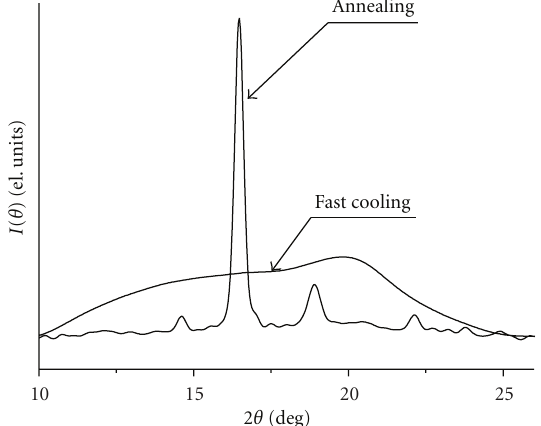
Figure 5: X-ray di ff ractograms for the CPL1/130 ◦ C films after annealing and fast